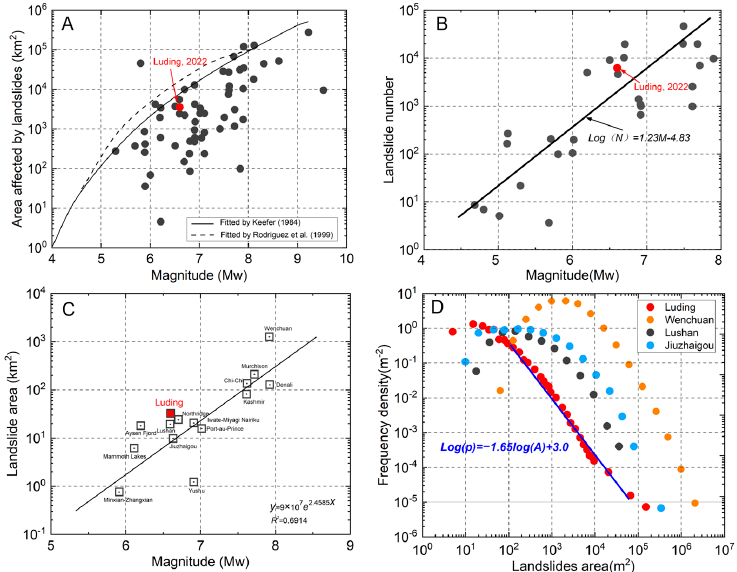
Figure 6. Comparison of landslide inventory caused by the 2022 Luding event with other events. ( A ) the earthquake magnitude and the area affected by coseismic landslides (the black circle represents other earthquake cases from [26,27]); ( B ) the earthquake magnitude and the number of landslides (other cases are referred from [33,42]); ( C ) the total area of landslides and earthquake magnitude; ( D ) the correlations of landslide area frequency density for the 2022 Luding event, the 2008 Wenchuan event, the 2013 Lushan event and the 2017 Jiuzhaigou event. The base map of ( C , D ) are referred from [18].